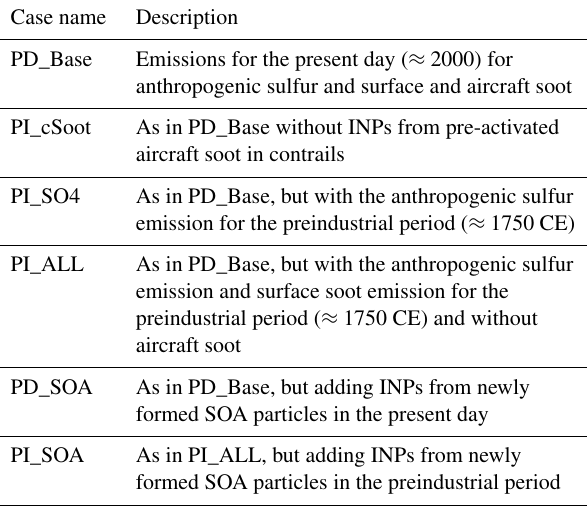
Table 2. Description of